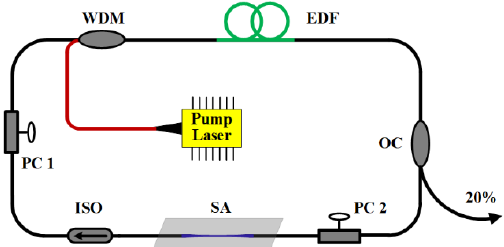
Figure 4. Diagram of an erbium-doped fiber mode-locked pulsed laser based on GDY-SA (WDM: wavelength division multiplexer, EDF: erbium-doped fiber, OC: optical coupler, PC: polarization controller, ISO: isolator).